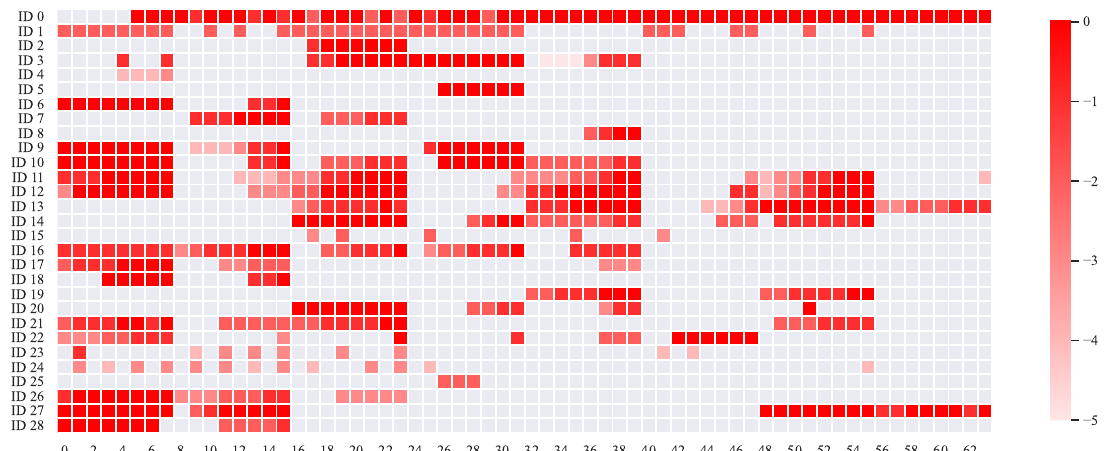
Figure 18. Bit-flip magnitudes for 29 unique CAN IDs are visualized. A larger magnitude value represents a more frequent change for a particular bit.